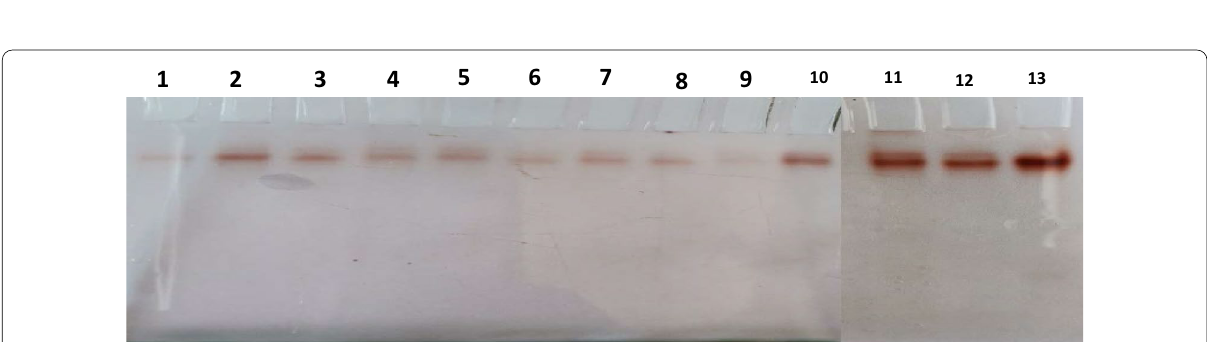
Fig. 6 Electrophoretic patterns of the peroxidase isozymes for the 13 rice genotypes under drought conditions. Lane 1: 8 9: 13 the highest five hybrids, =